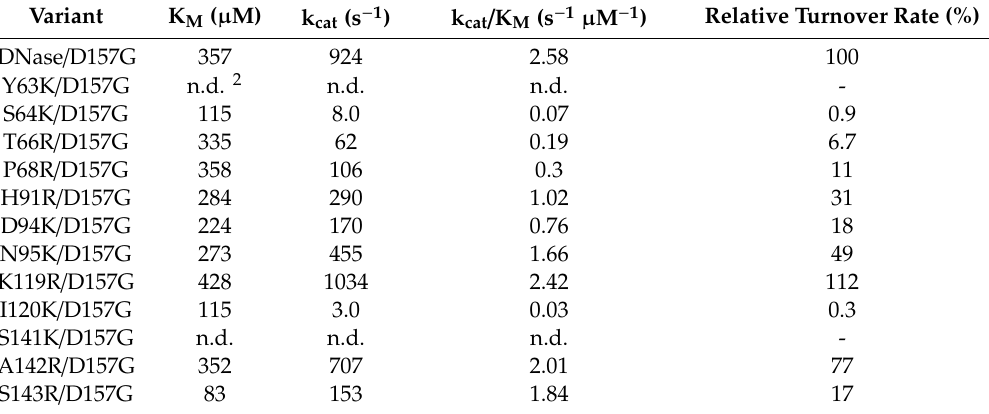
Table 2. Kinetic characteristics of nuclease mutants 1